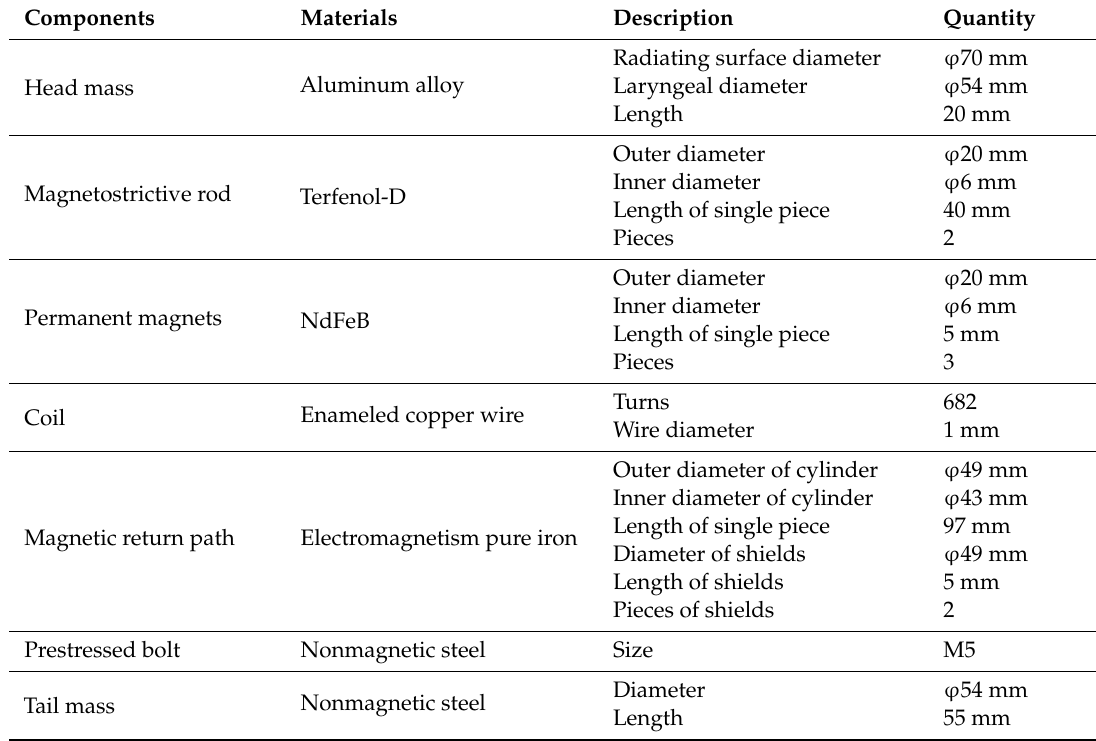
Figure 1. Schematic diagram of a Terfenol-D transducer. Table 1. The materials and sizes of the Terfenol-D transducer’s main components.